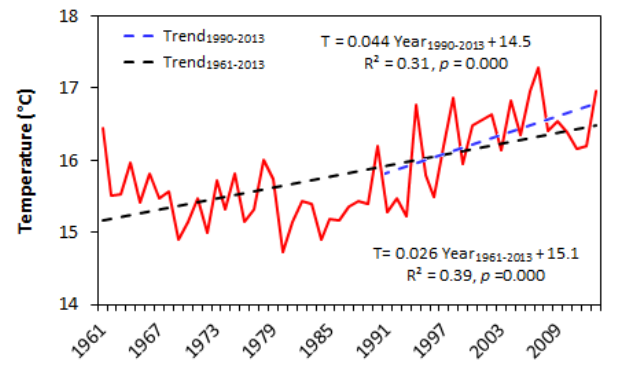
Figure 3. Mean annual air temperature change across four meteoro- logical stations in the Qinhuai River basin in southern China during 1961–2013.